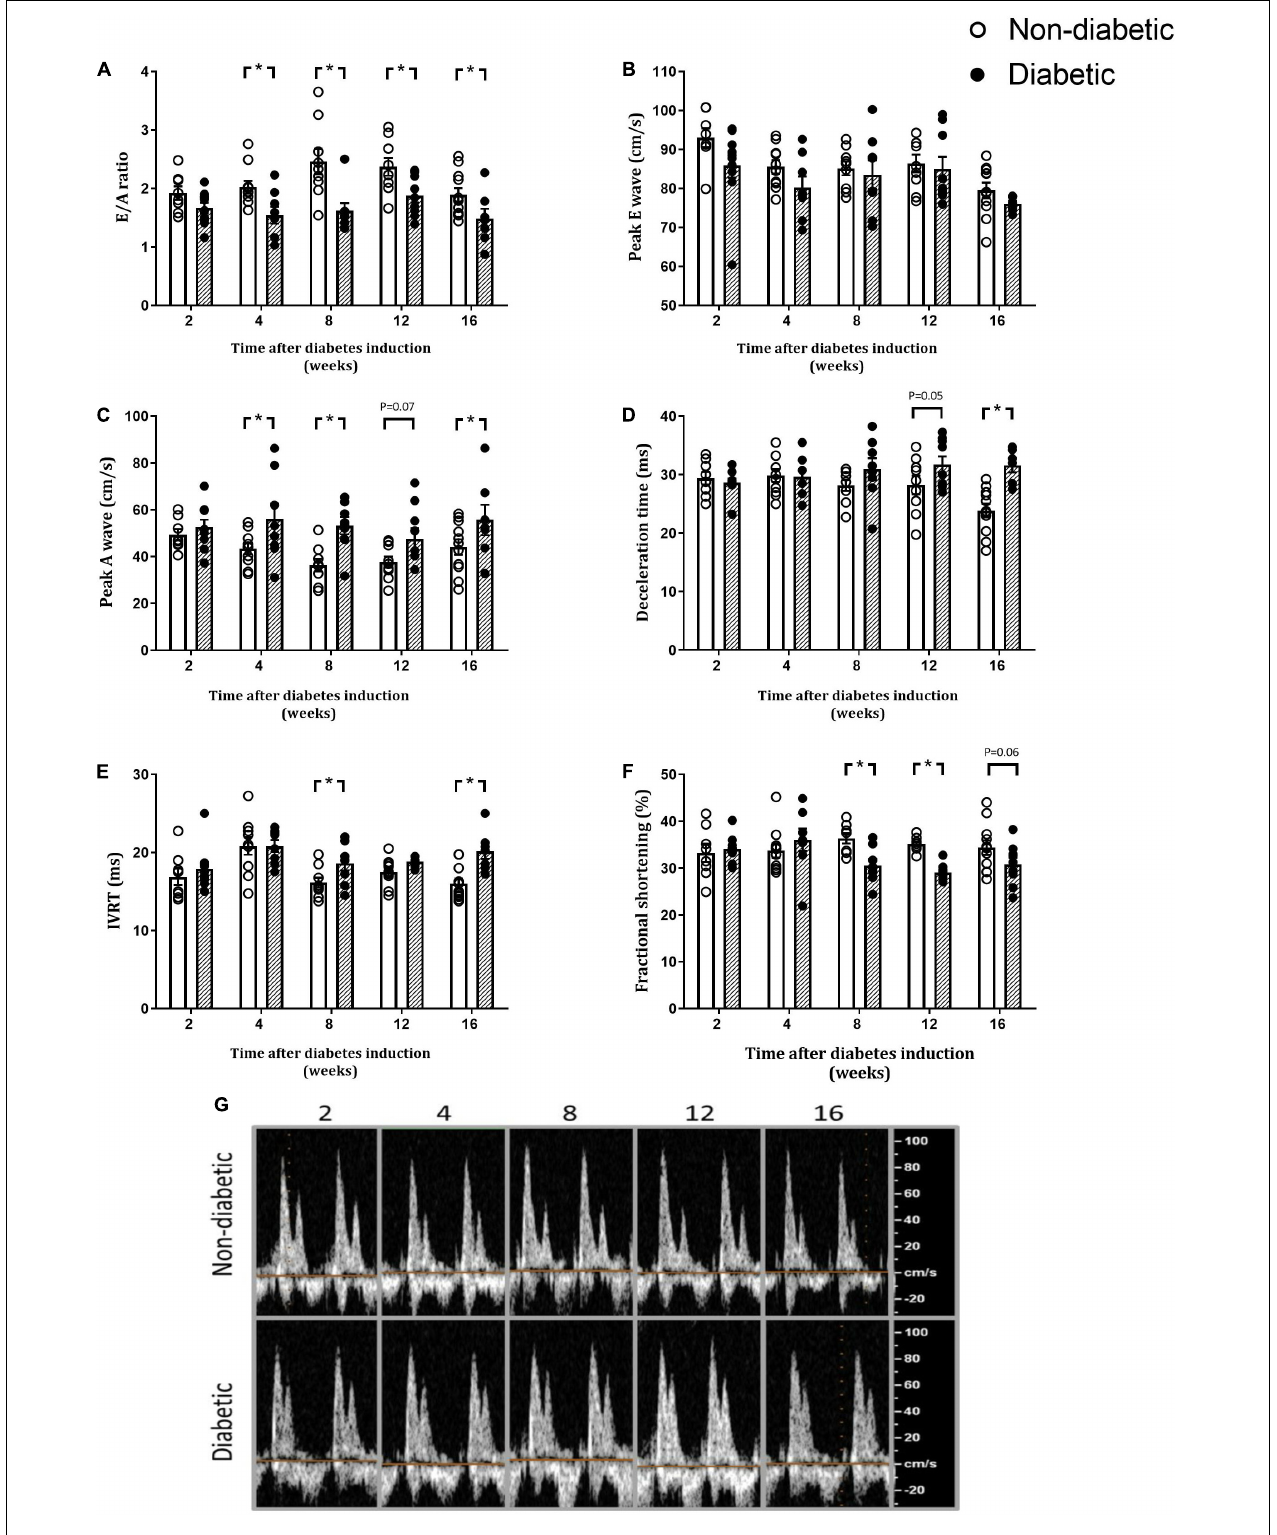
FIGURE 3 | Diabetes progressively worsens markers of diastolic and systolic function. E/A ratio (A) , peak E wave (B) , peak A wave (C) , Deceleration time (D) , IVRT (E) , fractional shortening (F) , and representative doppler images (G) are shown. Data are presented as mean ± SEM. * P < 0.05 vs age-matched non-diabetic mice (two-way ANOVA with Benjamini and Hochberg post hoc test). Representative images for each endpoint Doppler echocardiograph are shown. n = 7–11/group (refer to Supplementary Figure S1 ).